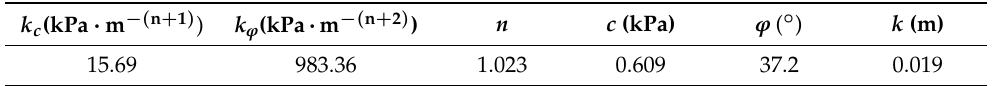
Table 1. The mechanical parameters of JLU